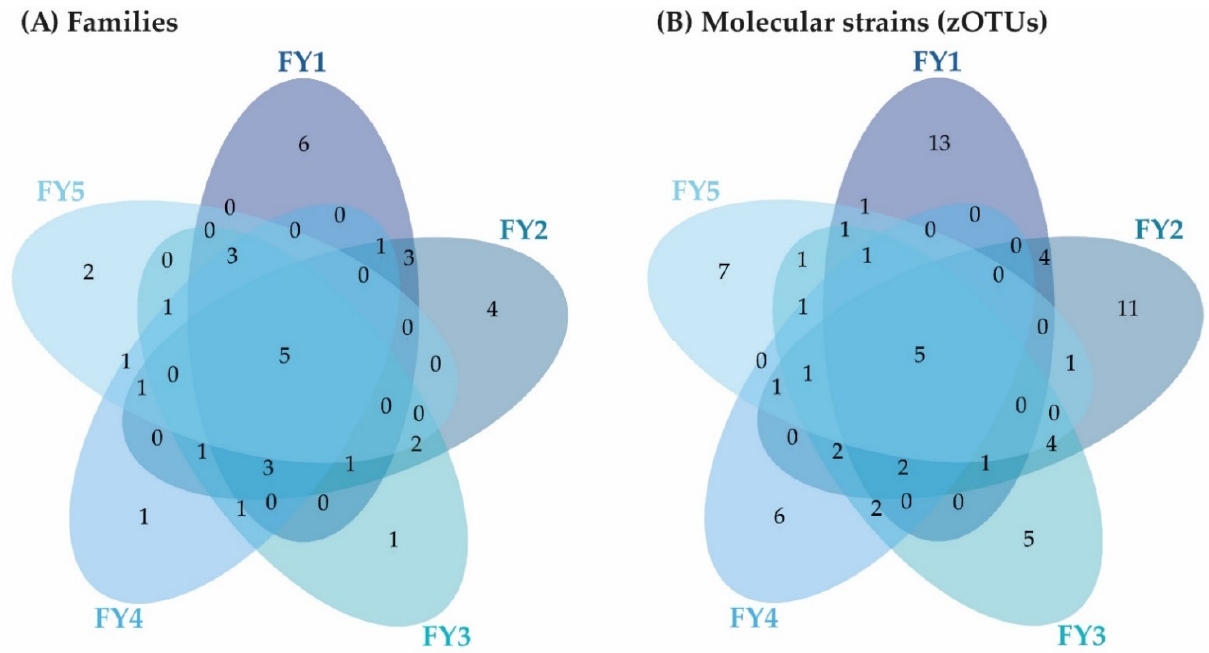
Figure 11. Venn diagram depicting unique and shared families ( A ) and molecular strains (zOTUs) ( B ) among the fry stages (FY1–FY5; cut-off: 0.5% mean relative abundance). FY1, fry 69 dpf; FY2, fry 74 dpf; FY3, fry 82 dpf; FY4, fry 88 dpf; FY5, fry 95 dpf; dpf, days post fertilization.